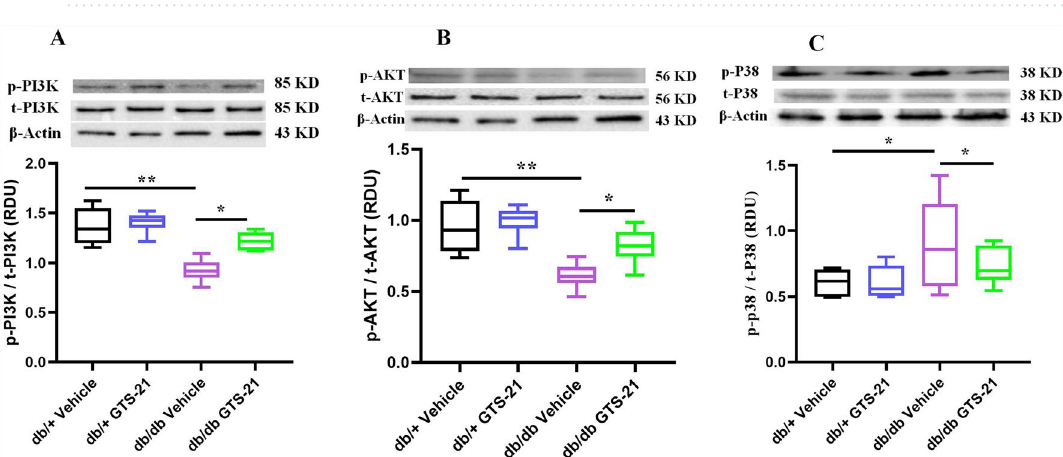
Figure 5. Activation of the PI3K/AKT and p38 MAPK pathways in db/db mice. Mice were treated with GTS-21 (4 mg/kg, IP, B.I.D.) or vehicle for 8 weeks. Renal lysate was prepared, then phosphorylated and total PI3K, AKT and p38 protein were assayed by Western blot. Densitometry data for phosphorylated and total PI3K ( A ), AKT ( B ) and p38 ( C ) were normalized and presented as RDU. The data is represented as mean ± SE (n = 4–5/group), NS no significant difference, * P < 0.05, ** P <